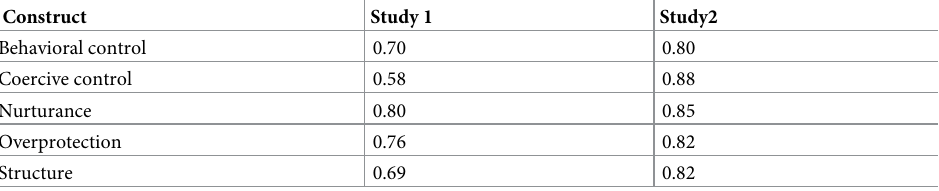
Table 5. Results for the average variance extracted (AVE) for each